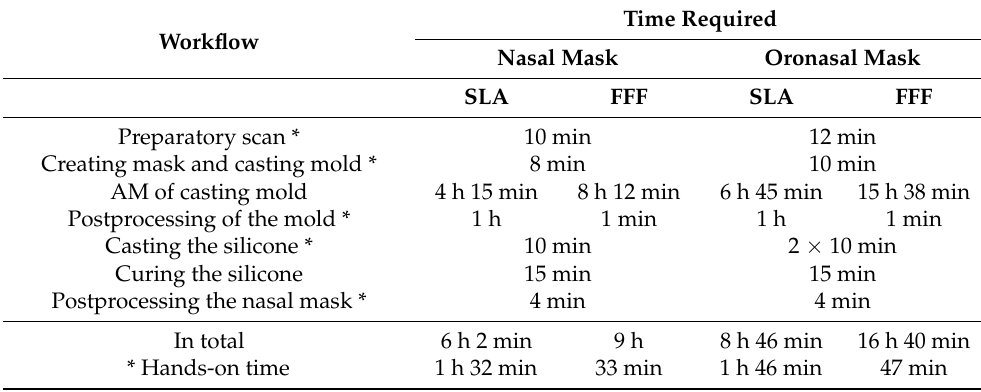
Table 3. The required time for manufacturing a single nasal and oronasal mask. The time was taken for FFF and SLA-method. Hands-on time consists of the steps indicated by *. Time Required Workflow Nasal Mask Oronasal